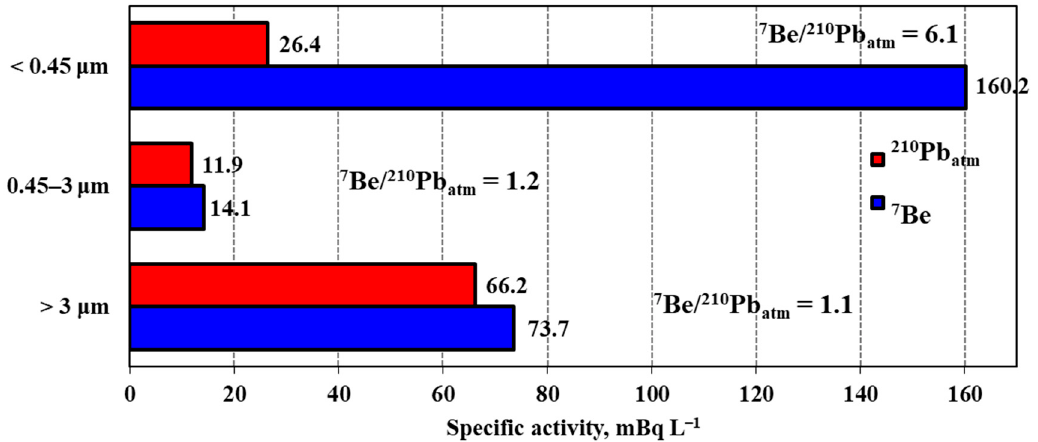
Figure 7. Average values of 7 Be and 210 Pb atm specific activities in the particulate fractions of suspended matter in snow water.